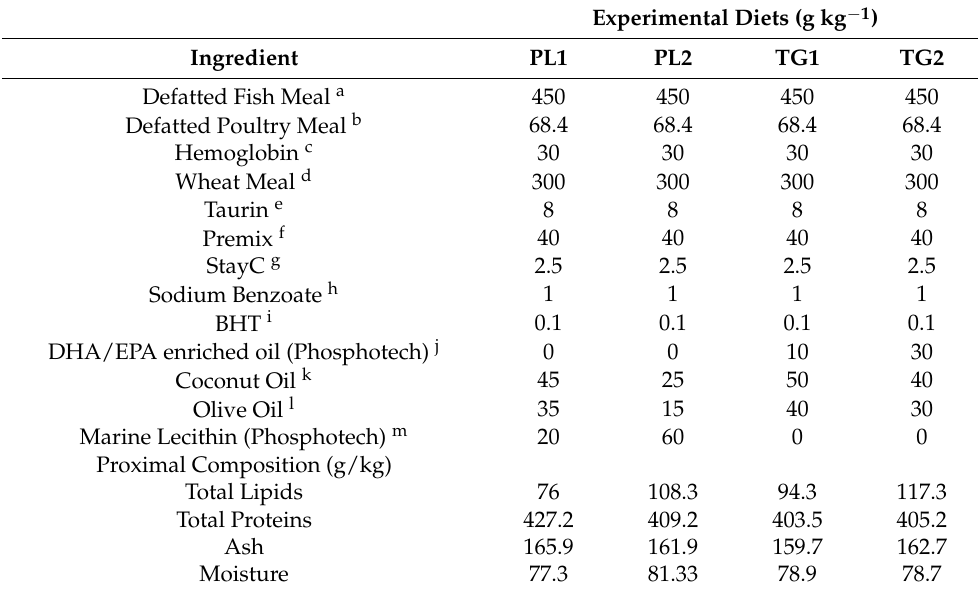
Table 1. Dietary formulation and proximal composition (g kg − 1 ).